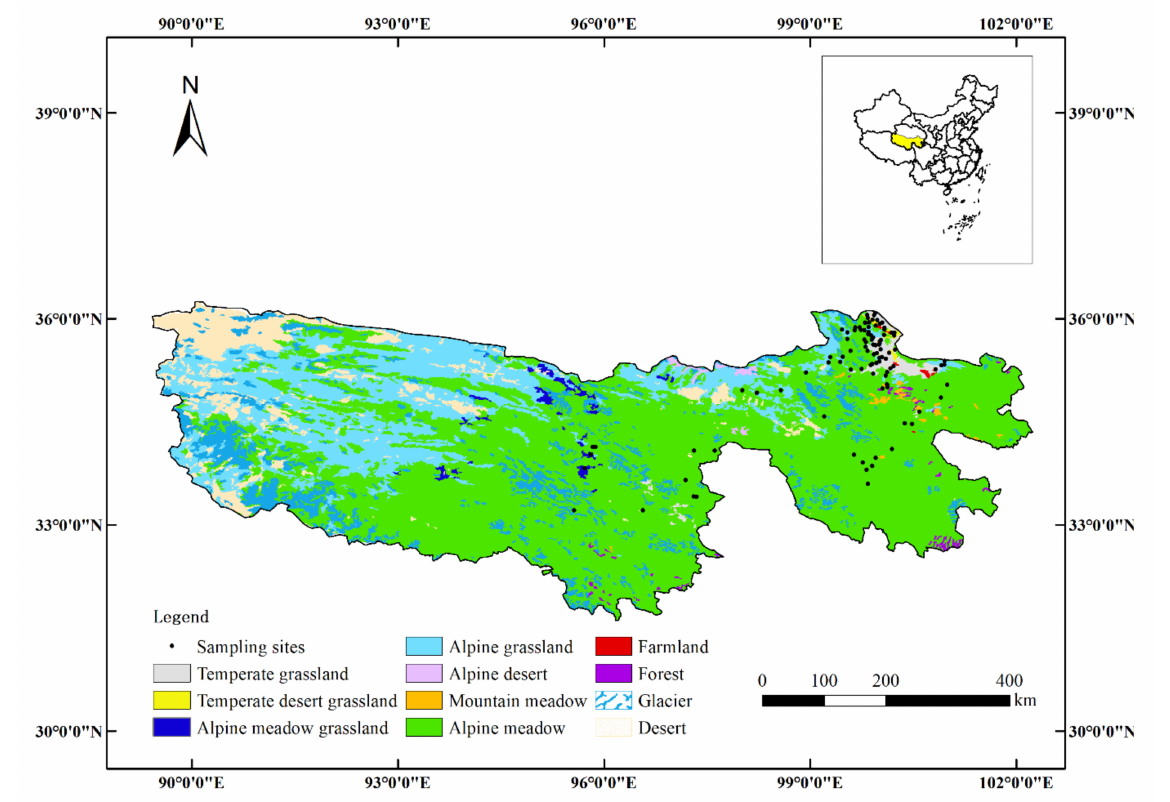
Figure 1. Distribution of soil sampling sites and different vegetation types in the Three-Rivers Source Region.